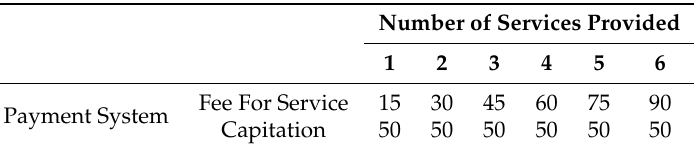
Table 4. Physician payoff by service provision.